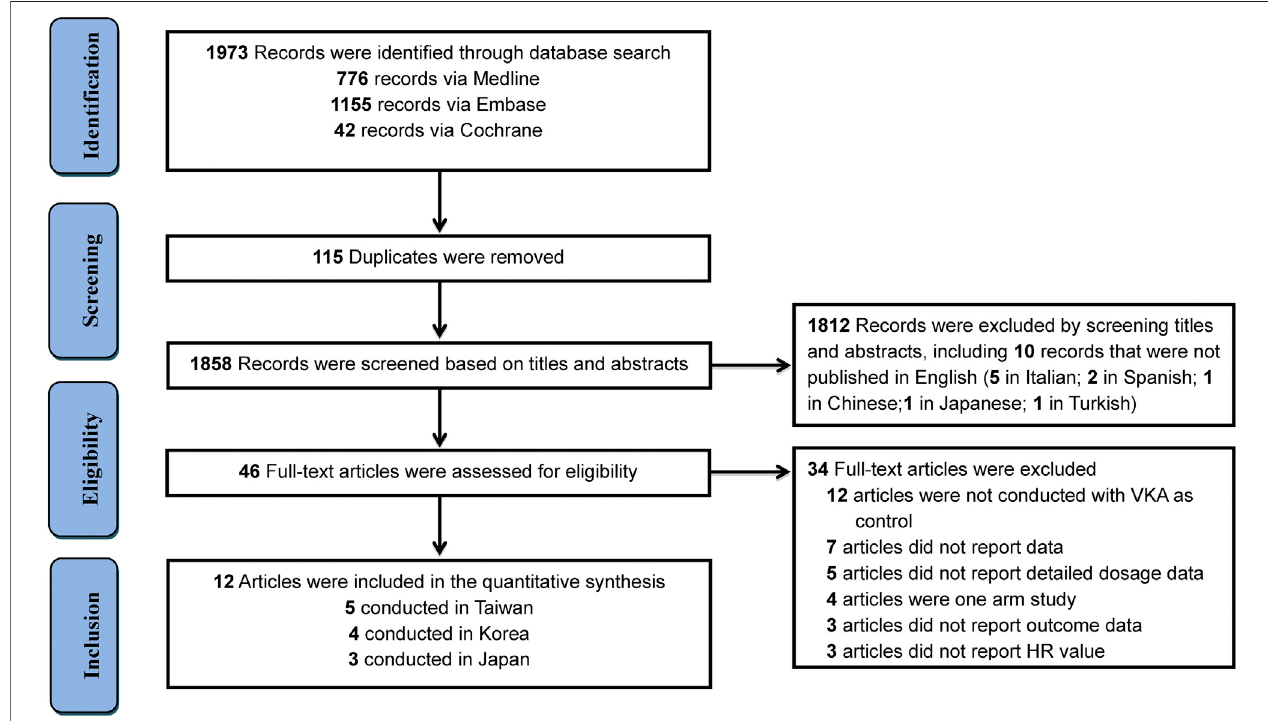
FIGURE 1 | Flow diagram for the selection of eligible